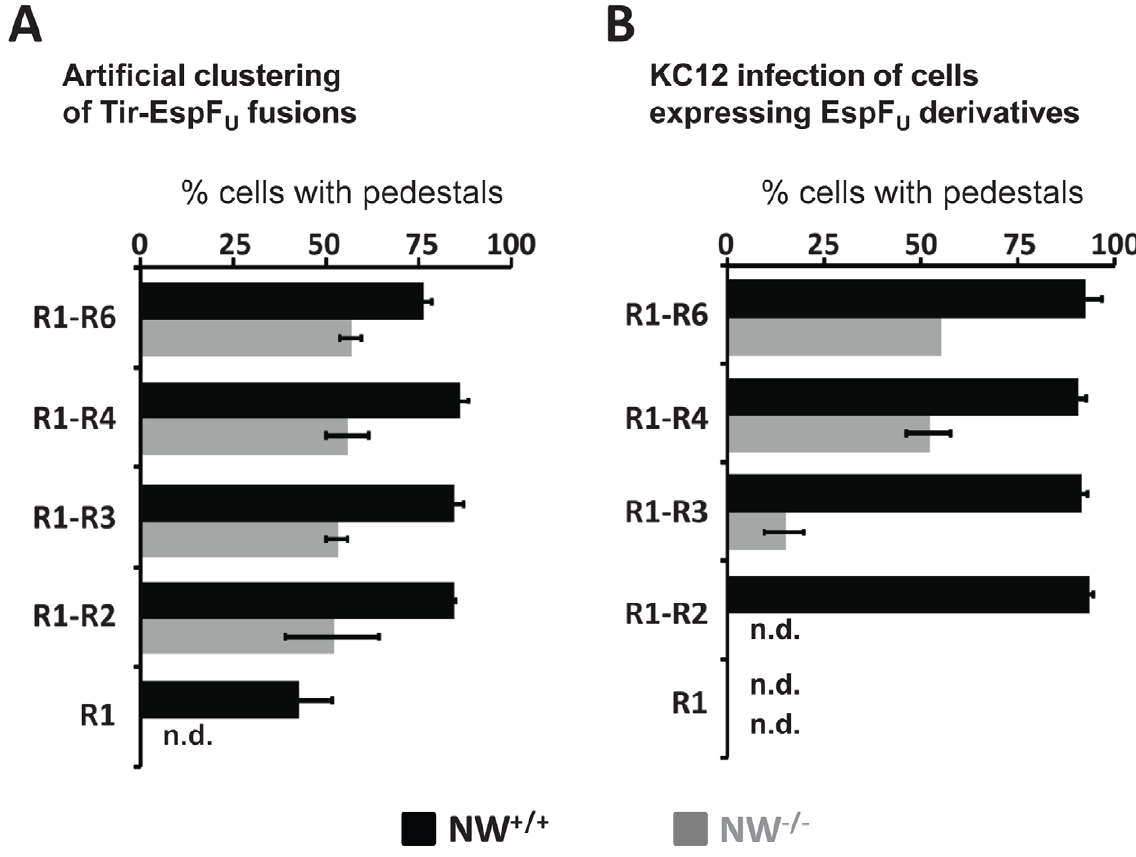
Figure 8. Pedestal formation on N-WASP-deficient cells requires multiple EspF U repeats. ( A ) NW 2 / 2 cells (shaded bars) ectopically expressing Tir-EspF U fusion derivatives were treated with anti-Tir antibodies and S. aureus particles to promote membrane clustering. Monolayers were stained with anti-HA antibody to identify both transfected cells and S. aureus (which binds the fluorescent antibodies) and with Alexa568- phalloidin to detect F-actin. The pedestal formation indices were determined by calculating the percentage of transfected cells harboring five or more S. aureus particles associated with actin pedestals. These experiments were performed in parallel with NW + / + cells (solid bars), the results of which were previously published [28] and are shown here for comparison. Data represent the mean 6 SD from three experiments. ( B ) NW 2 / 2 (shaded bars) ectopically expressing GFP-EspF U fusion derivatives were infected with EPEC KC12 and monolayers stained with DAPI to identify attached bacteria, anti-myc antibody to enhance detection of GFP-EspF U fusion and Alexa568-phalloidin to detect F-actin. The pedestal formation indices were determined by calculating the percentage of transfected cells harboring five or more actin pedestals. These experiments were performed in parallel with NW + / + (solid bars) cells, the results of which were previously published [28] and are shown here for comparison. Data represent the mean 6 SD from three experiments. ‘‘n.d.’’; not